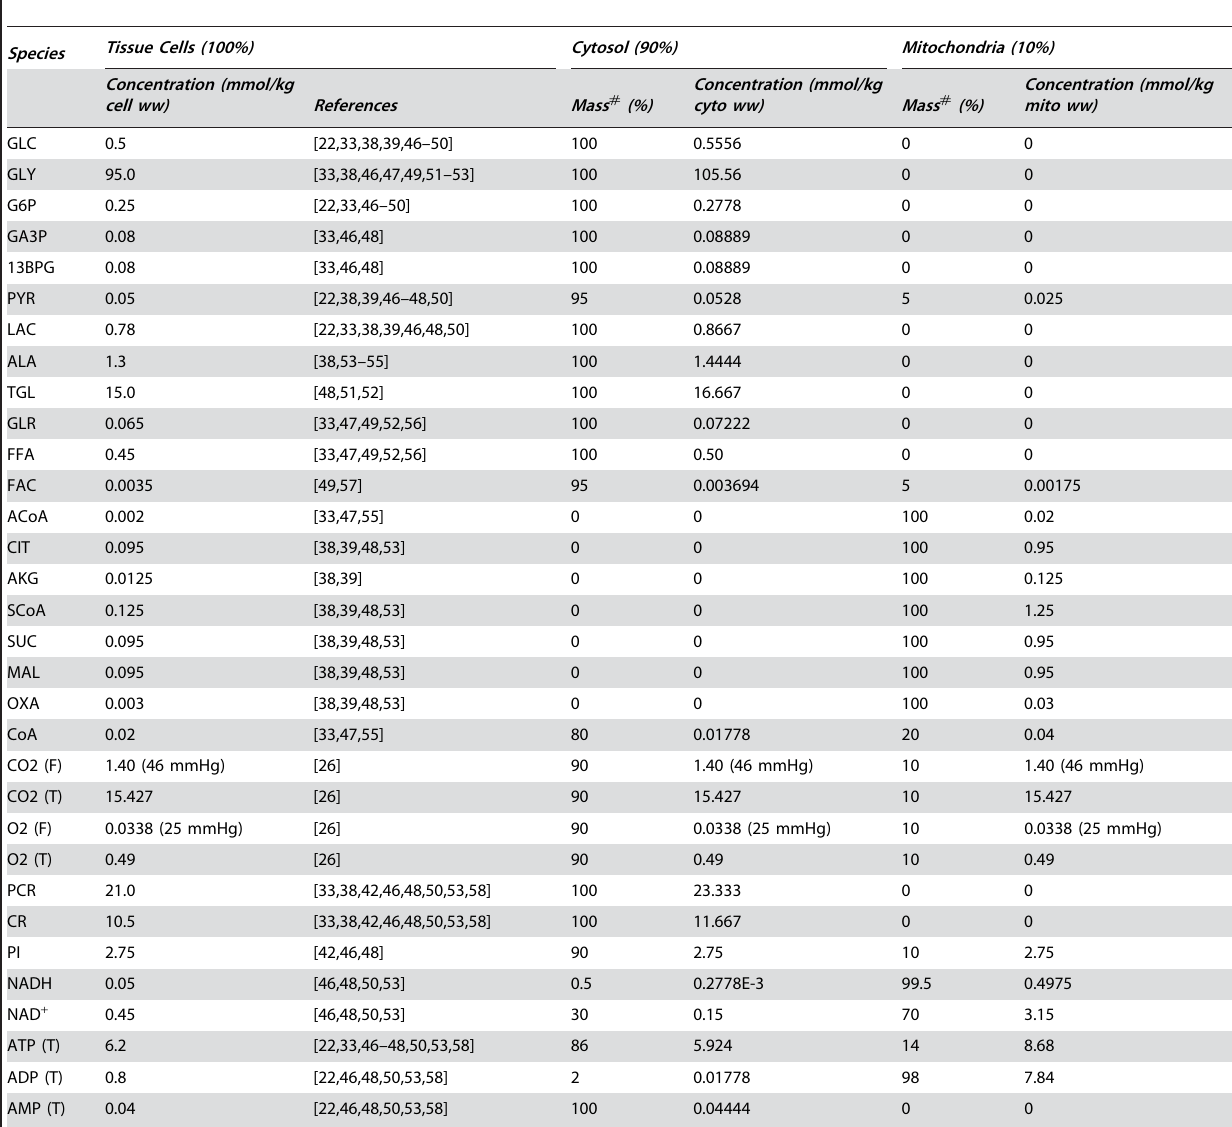
Table 1. Average species concentrations in the muscle tissue cells [1] and their compartmentalization (distribution) into cytosol and mitochondria at normal, resting steady-state